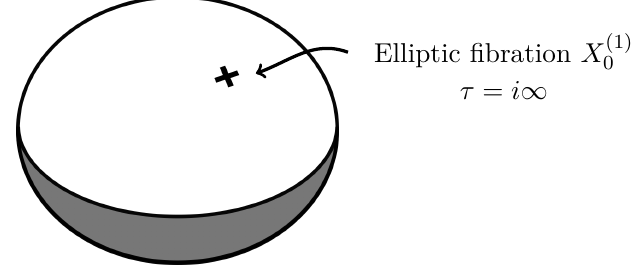
Figure 1 . The stringy Kähler moduli space of Weierstraß curves is the modular curve X 1 (1) . Also for a Calabi-Yau fibration of Weierstraß curves, the large volume points in the SL(2 , Z ) orbit of τ = i ∞ are physically